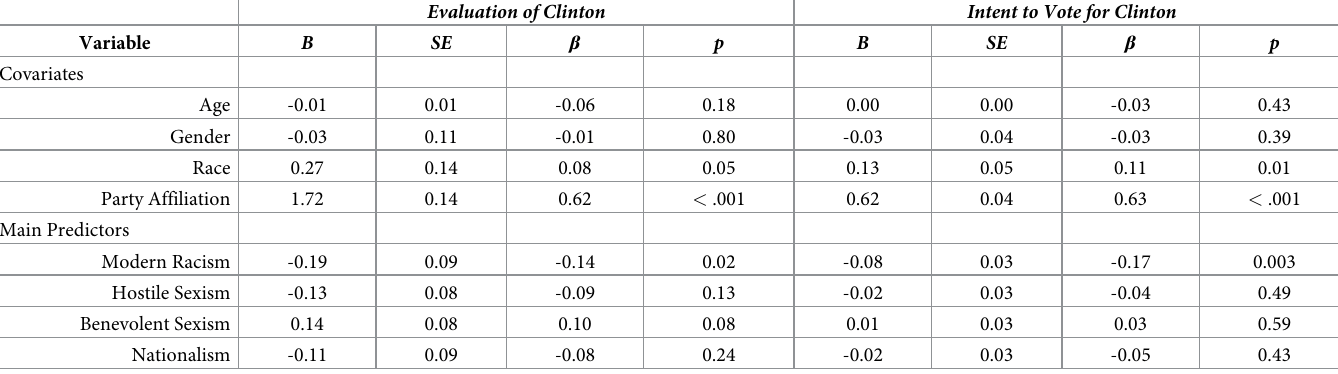
Table 3. Standardized estimates, unstandardized estimates, and standard errors for structural model predicting evaluation of Clinton and intent to vote for Clinton at Time 1. Evaluation of Clinton